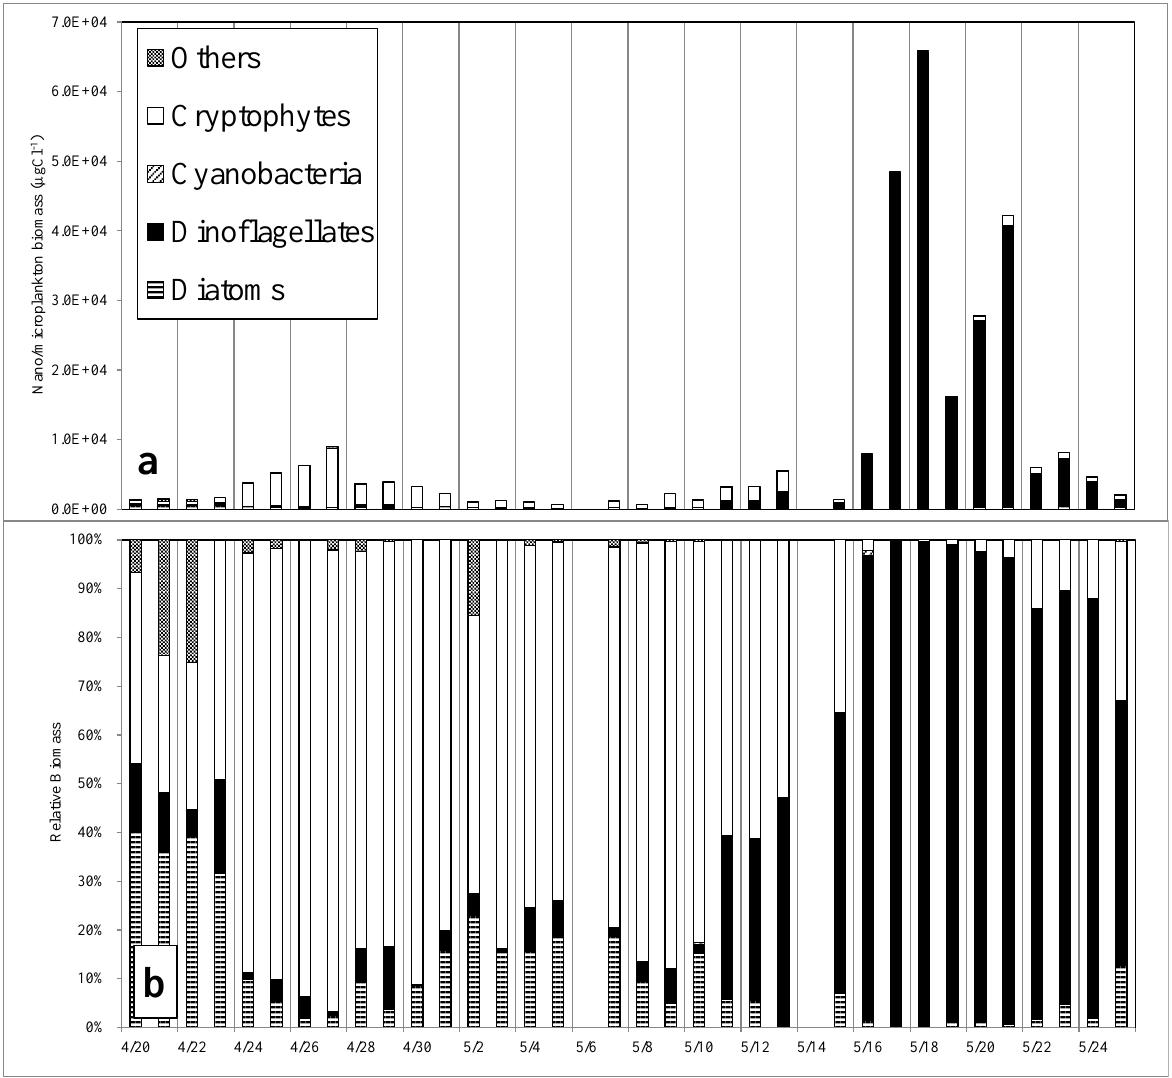
Figure 4. Biomass (µg C L −1 ) of the major taxonomic groups within the Lafayette River from 20 April to 25 May shown as absolute algal biomass for each major taxonomic group ( a ) and each taxonomic group as a percentage of the total algal biomass ( b